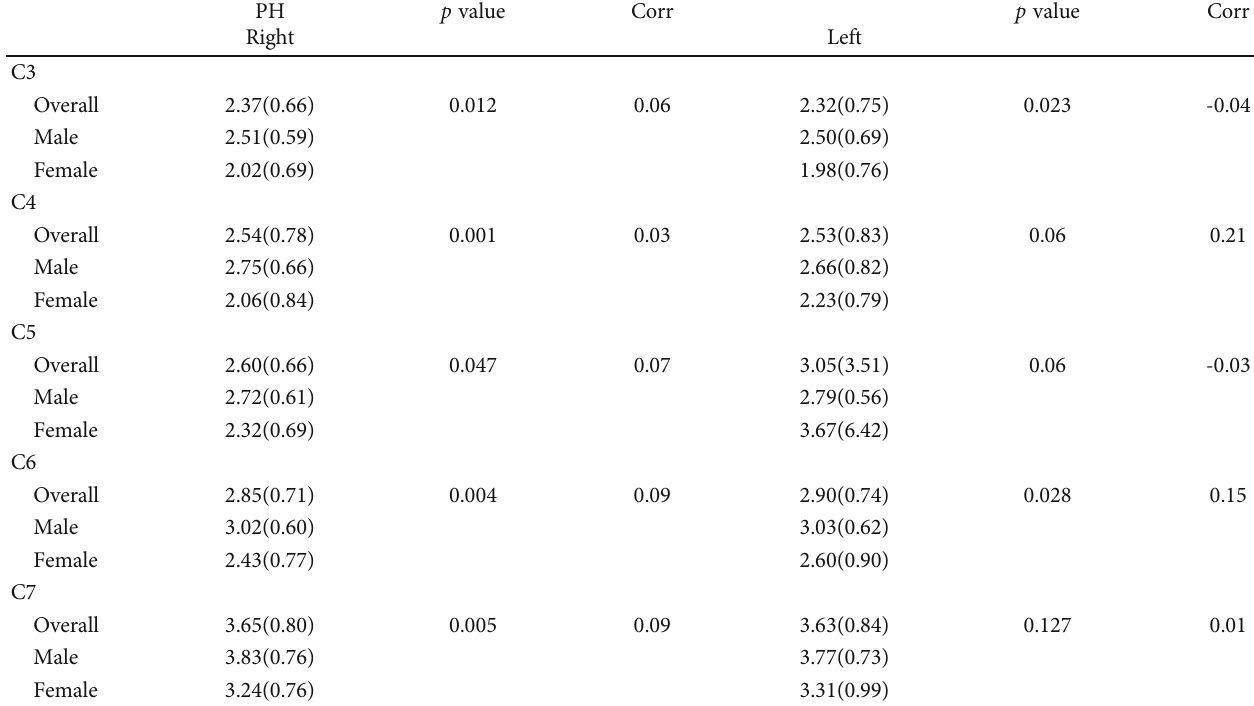
Table 4: Pedicle height of 70 participants.